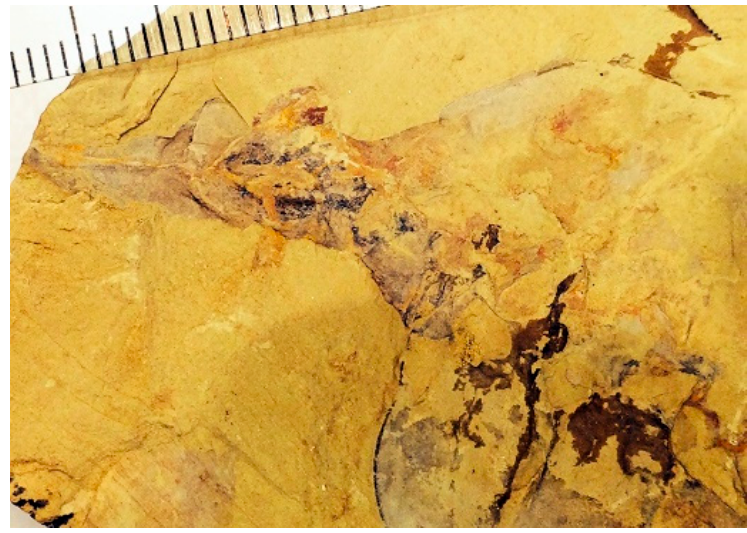
Figure 19. Shenzianyuloma yunnanense nov. gen. nov. sp. IGM 5008. Posterior region of animal. Scale in mm. Photo Credit: Mark McMenamin.